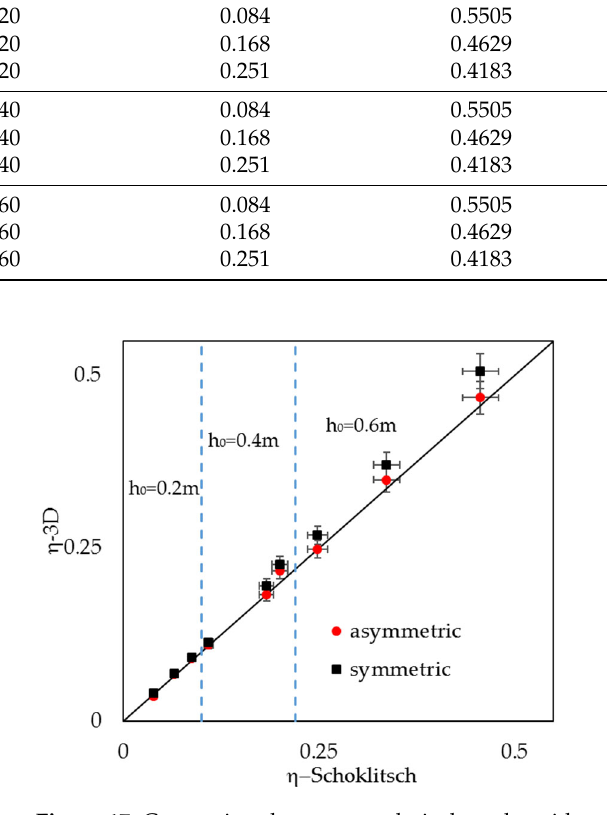
Figure 17. Comparison between analytical results with numerical ones.